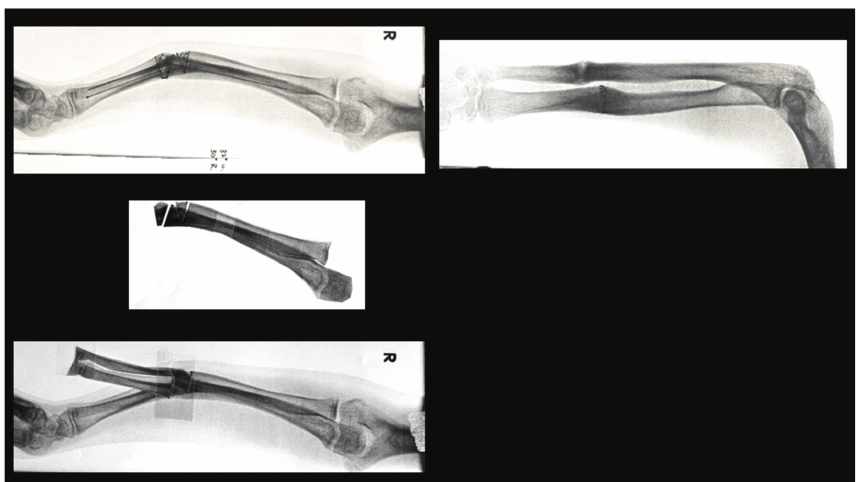
Figure 3: Preoperative planning—defining the osteotomies.